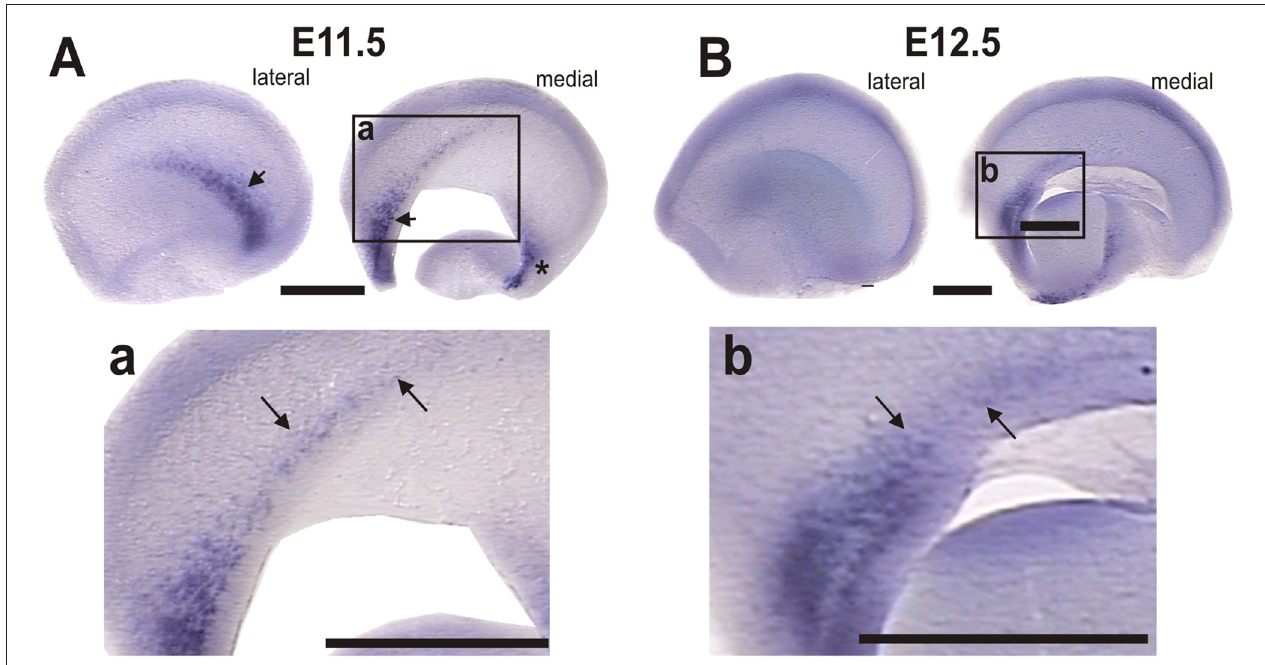
FIGURE 7 | Dbx1 is expressed in the rostral-most region of the cortical hem. Dbx1 ISH in WT mouse telencephalic vesicles. (A) E11.5 lateral and medial views; arrows indicate Dbx1 expression in the olfactory region and septum; asterisk indicates the caudomedial side. (a) Higher magnification of inset in (A) ; arrows indicate Dbx1 expression in the rostral end of the prospective cortical hem. (B) E12.5 lateral and medial side of telencephalic vesicles, showing reduced Dbx1 expression. (b) Dbx1 expression persists in the septum and in the rostral end of the cortical hem. Scale bar: 200 µ